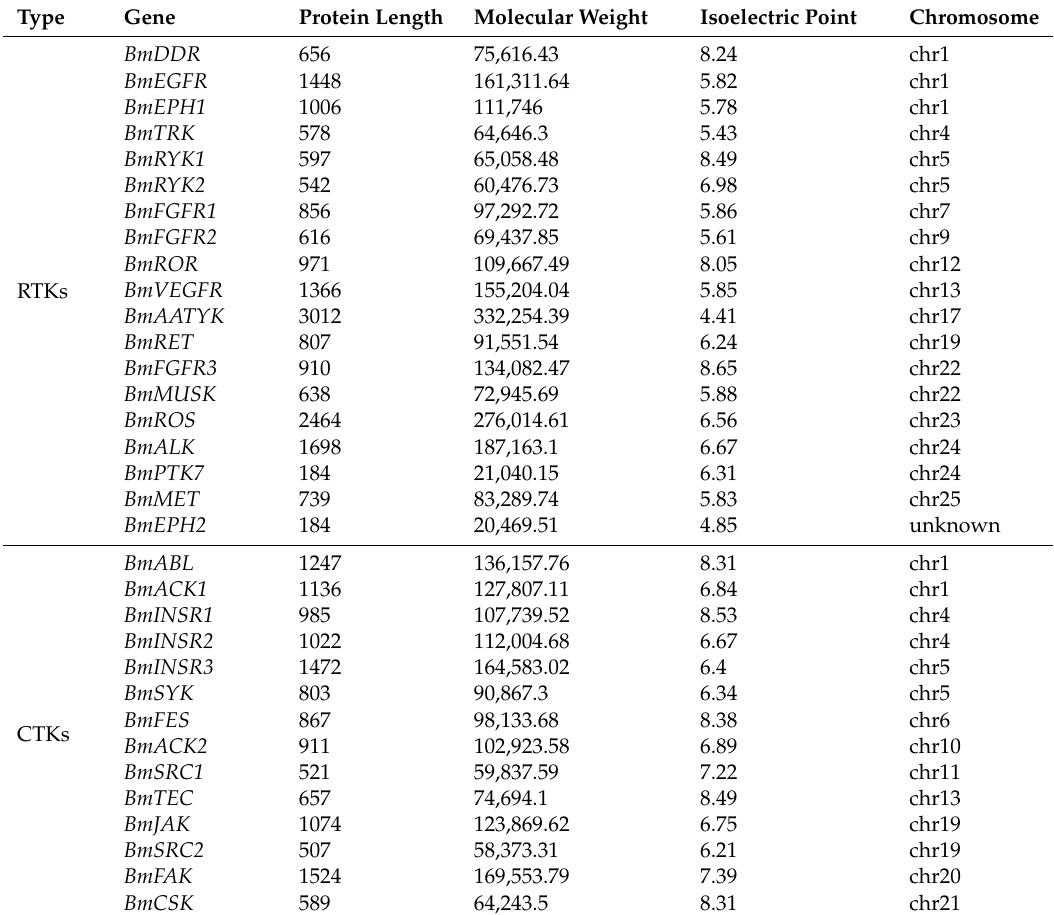
Table 1. Inventory of TK genes in the silkworm